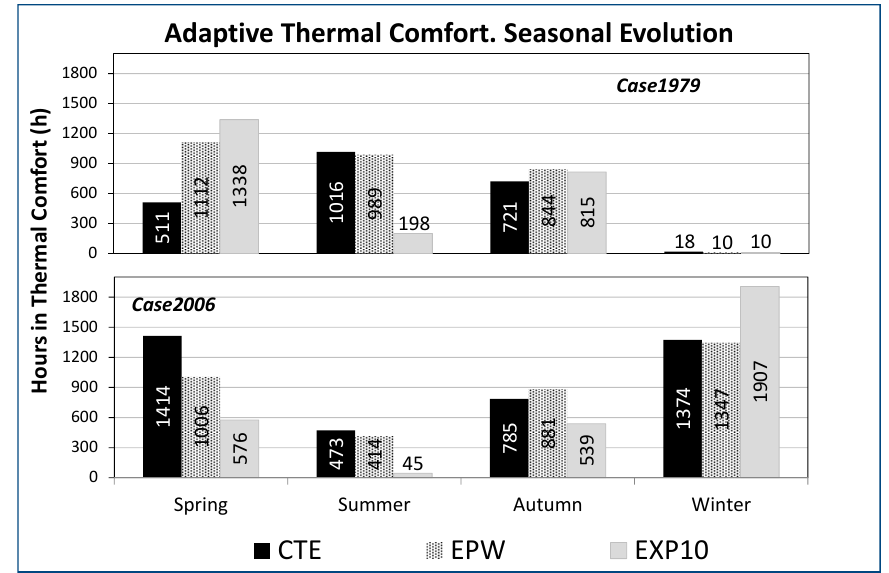
Figure 11. Number of hours in thermal comfort in each season, evaluating the three climate databases of Madrid: CTE, EPW and Exp-10, and for the two building models, Case 1979 and Case 2006.